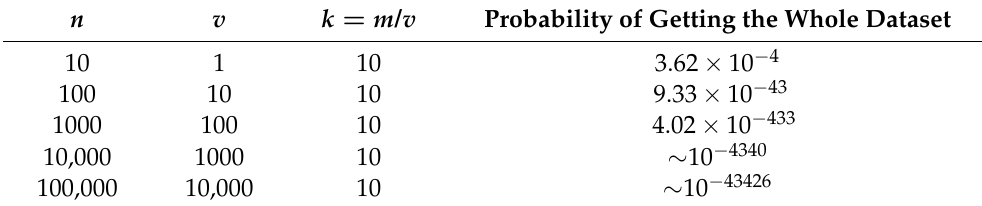
Table 2. Probability that the consumer gets the whole dataset if the provider makes 10 interactions with the consumer and discloses 10% of his dataset every